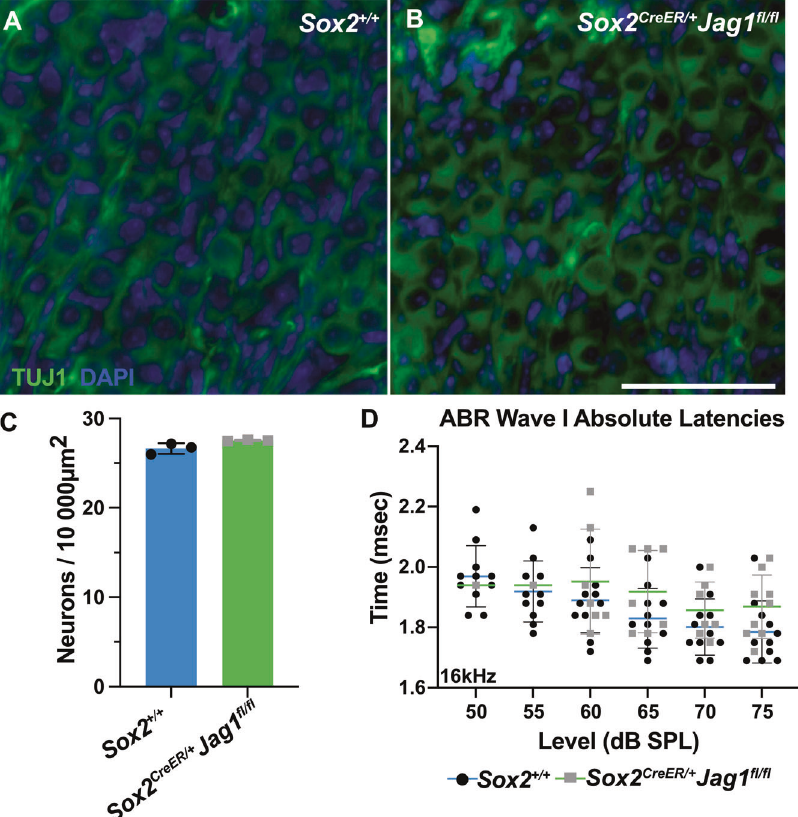
Fig. 3 Sox2 CreER/ + Jag1 fl / fl mice have spiral ganglion neurons and normal ABR wave I absolute latencies. A , B Representative images of spiral ganglion neurons from single optical sections stained for anti-Tubulin β -III (TUJ1, green) and nuclei (DAPI, blue) in P6 Sox2 + / + littermate control ( A ) and Sox2 CreER/ + Jag1 fl / fl mutant mice ( B ). Scale bar: 50 µm. C Average number of spiral ganglion neurons (SGN) per unit area (10,000 µm 2 ) in Rosenthal ’ s canal for P6 Sox2 + / + littermate control (black circles, blue mean bar) and Sox2 CreER/ + Jag1 fl / fl mutant (gray squares, green mean bar) mice are not signi fi cantly different. Data expressed as mean ± SD. Unpaired two-tailed Welch ’ s t test. n = 3 per genotype. D ABR wave I absolute latencies at 16 kHz for control (black circles, blue mean bar) mice and Sox2 CreER/ + Jag1 fl / fl mutants (gray squares, green mean bar) are not signi fi cantly different at 6 weeks. Data expressed as mean ± SD. Two-way ANOVA Bonferroni adjusted. Sox2 + / + n = 11, Sox2 CreER/ + Jag1 fl / fl n = 12.